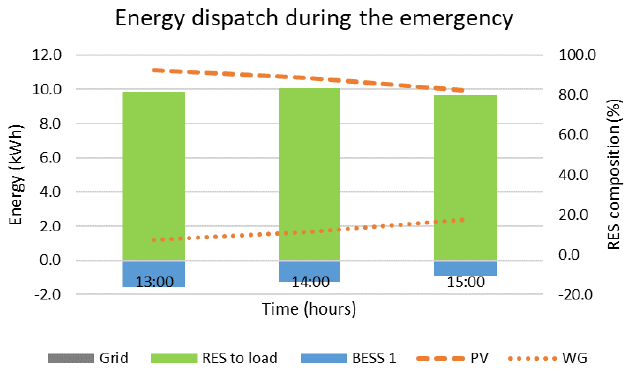
Figure 6. Energy stored in BESS 1 if BESS 2 is disconnected from 13:00 to 16:00.